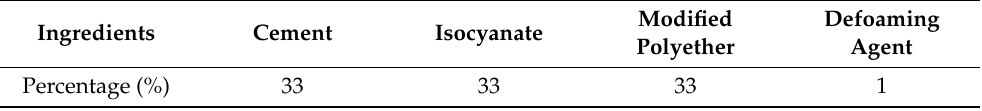
Table 1. The mass ratio of each component of PUC.